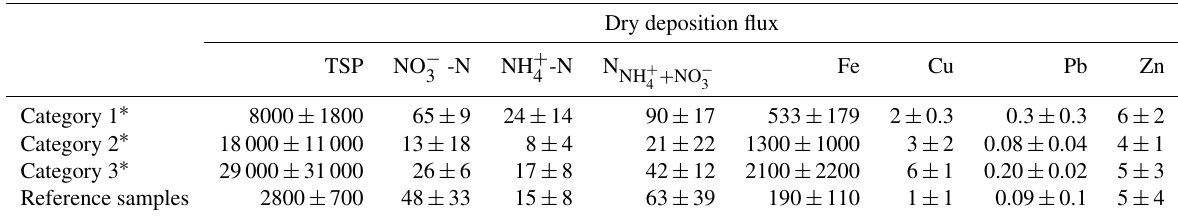
Table 8. Dry deposition of TSP (mgm − 2 month − 1 ), N and reference